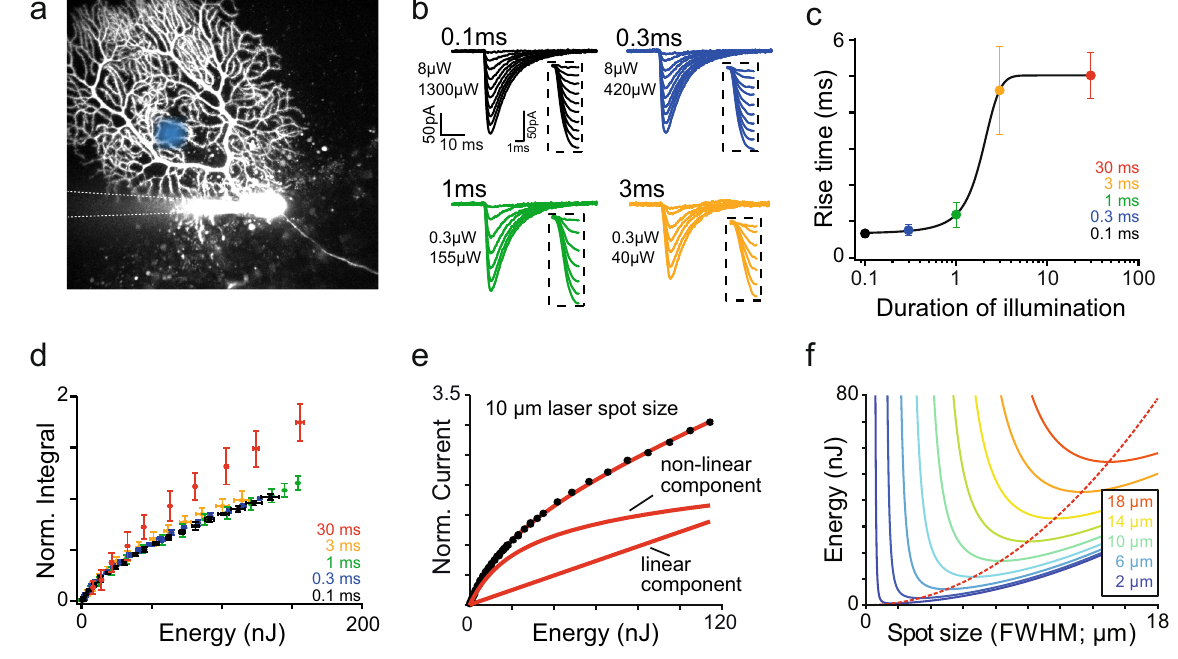
Figure 3. Calibration of ChR2 activation by Gaussian beams. ( a ) Schematic for experimental configuration with two-photon image of Purkinje cell filled with morphological dye (Alexa 594, 15 µ M) via recording pipette in L7-ChR2-YFP mouse expressing ChR2 with schematic position of laser single beam (blue circle). ( b ) Average traces of whole-cell currents recorded from the soma of the Purkinje cell in response to single beam (~10 µ m) stimulation of the dendritic tree with different duration of illumination and at increasing light intensity. Each trace is the average of 10 stimulations. Values in µ W indicate the smallest (top) and highest (bottom) power used in the power increment protocol. Activation of each average for a given duration of illumination is enlarged in inset on the right side of each trace. c . Dependence of the rise time of the light-evoked currents (in ms) on the duration of illumination (presented in logarithmic scale). Stimulation duration averages are colour coded (black: 0.1 ms, blue: 0.3 ms, green: 1 ms, orange: 3 ms and red: 30 ms). Data points represent the mean ± s.d. (n = 6 cells). ( d ) Integral of the light-evoked currents as a function of energy. For pulses of 3 ms and shorter, charge carried by delivering the same amount of energy will remain the same – activation curve is similar regardless of duration of illumination. Each response curve corresponds to the traces shown in b. Data points are mean ± s.d. (n = 8 cells). ( e ) Recruitment curve for ChR2 currents recorded at the Purkinje cell soma for single beam stimulation of 0.1 ms. The curve is well fitted by our ChR2 current recruitment model (red curve) (see Methods). Below two components (linear and non-linear) are presented. Saturation energy for ChR2 obtained from this model is 0.067 nJ µ m − 2 . ( f ) Energy required to achieve ChR2 saturation within a circular area for a given size of the illumination spot. The different solid color curves indicate the size of the saturated region and the red-dash line the illumination spot size that provides saturation in a given region with the lowest amount of energy